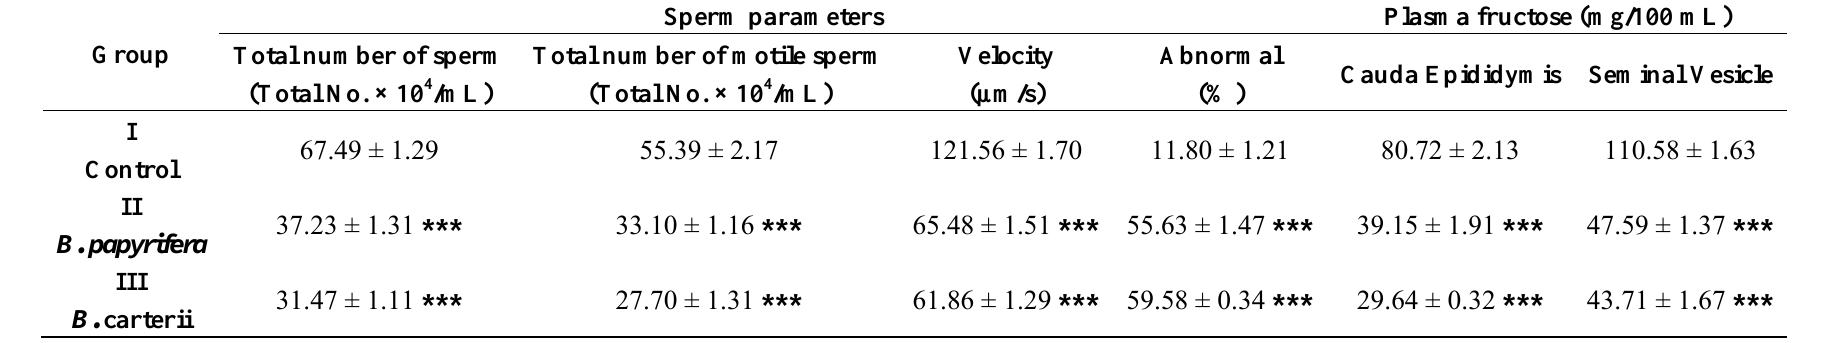
Table 1. Effect B. papyrifera and B. carterii smoke exposure on various sperm parameters and fructose content in cauda epididymal and seminal plasma of albino rats.